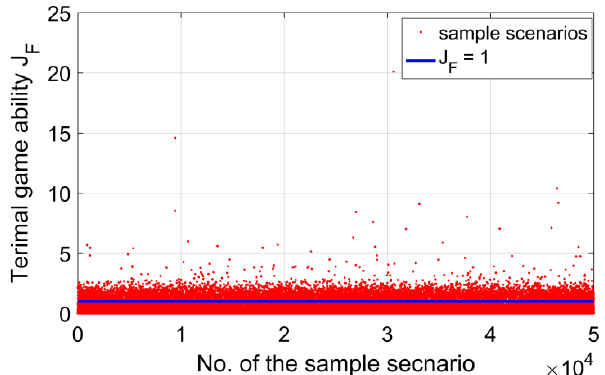
Figure 8. The terminal game capability of the pursuer J F in the FRS for 50,000 sample scenarios.